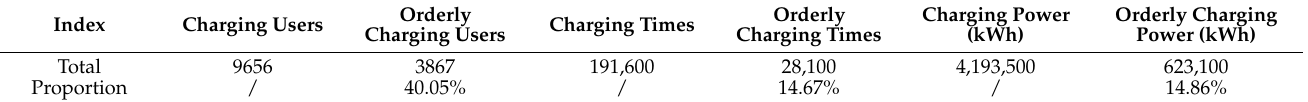
Table 1. Incentive verification experiment results.